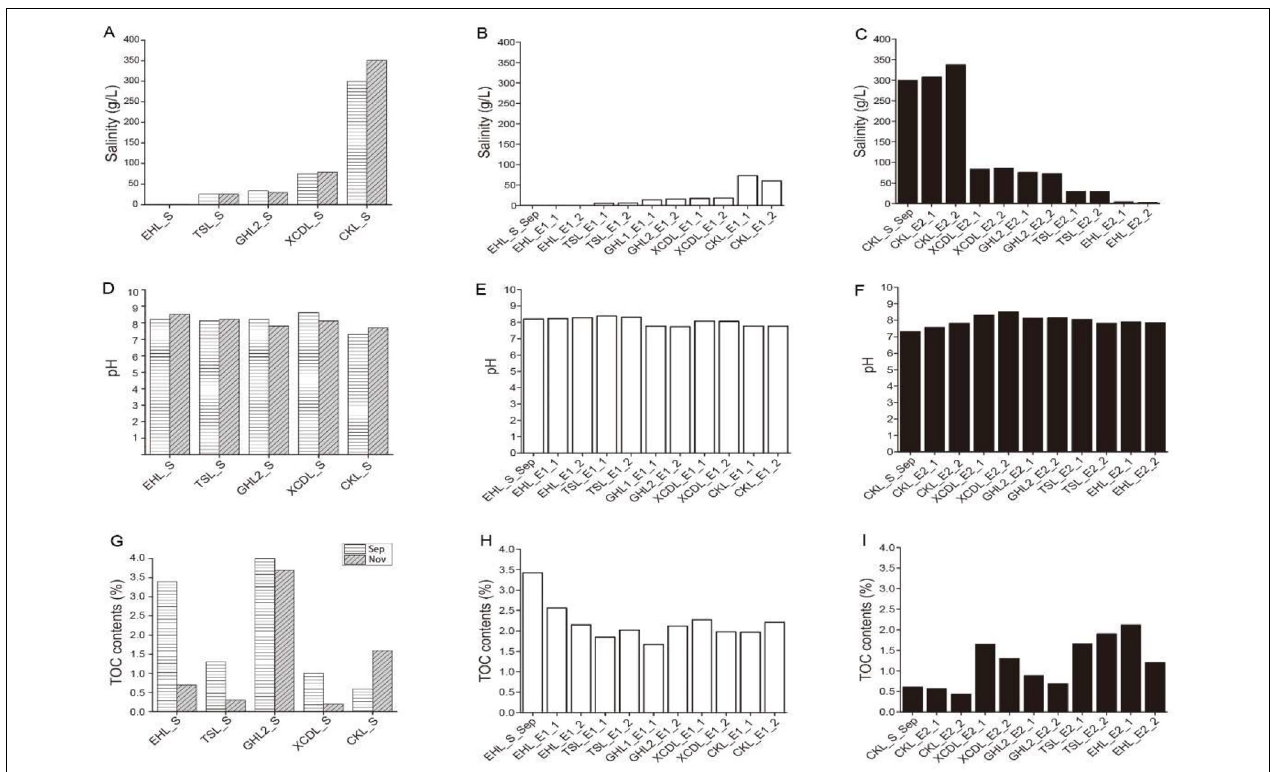
FIGURE 2 | Means of (A–C) salinity, (D–F) pH and (G–I) TOC contents in the lake and transplanted